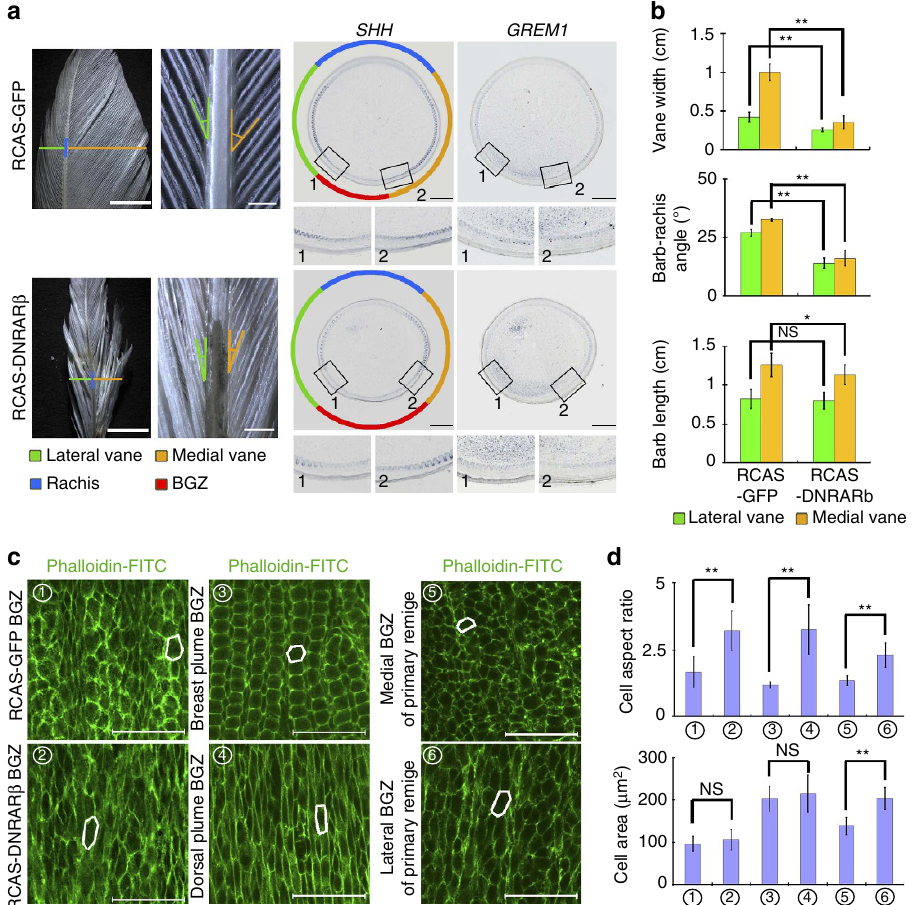
Figure 5 | RA signalling modulates vane morphology and epithelial cell shapes. ( a ) Compared with the controls, RCAS-DNRAR b infected adult chicken primary remiges have significantly reduced vane width and barb-rachis angles, while BGZ width is increased. Boxes highlight vane boundaries. Scale bars: leftmost panel: 5mm, right three panels: 500 m m. ( b ) Quantification of feather vane widths ( n ¼ 4), barb-rachis angles and barb lengths ( n ¼ 10) in control and DNRAR b infected remiges. Error bars denote s.d. (cid:2)(cid:2) P o 0.01, (cid:2) P o 0.05, NS, not significant. ( c ) BGZ epithelial cells have more elongated shape at epithelial regions exposed to lower RA levels. Phalloidin labels F-Actin that is mainly localized along epithelial cell boundaries. Scale bar, 50 m m. White lines highlight cell shape differences. ( d ) Quantification of cell aspect ratio and cell area in BGZ epithelial cells ( n ¼ 30). Error bars denote s.d. (cid:2)(cid:2) P o 0.01, (cid:2) P o 0.05, NS, not